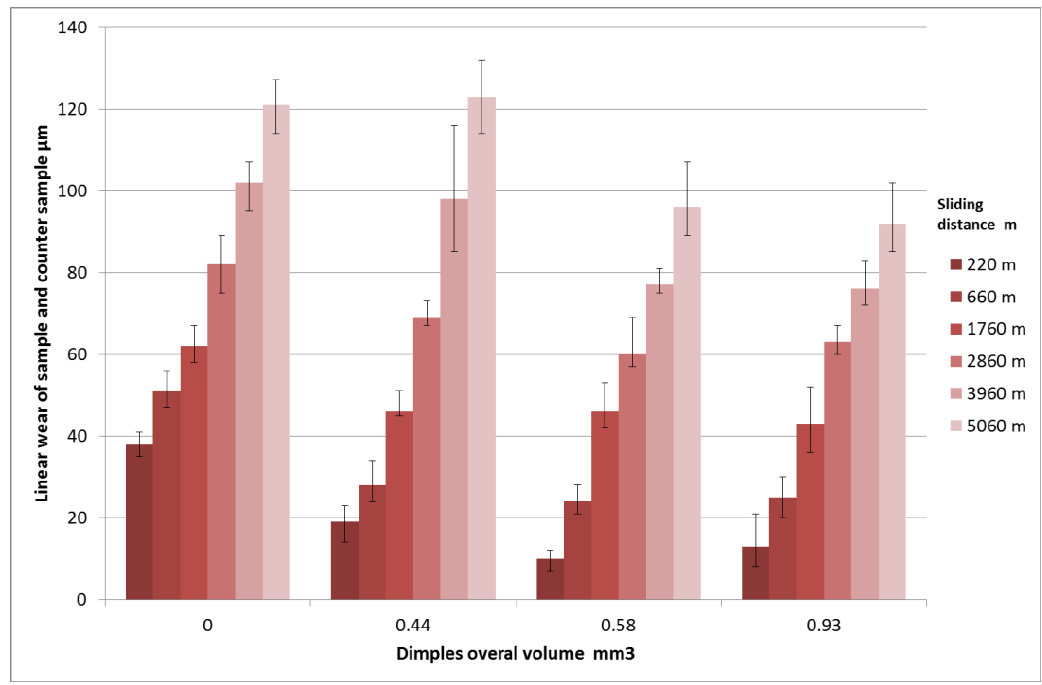
Figure 6. The effect of oil capacity of textured surface on linear wear of a tribological system. The beneficial effect of surface texturing on the tribological performance of the